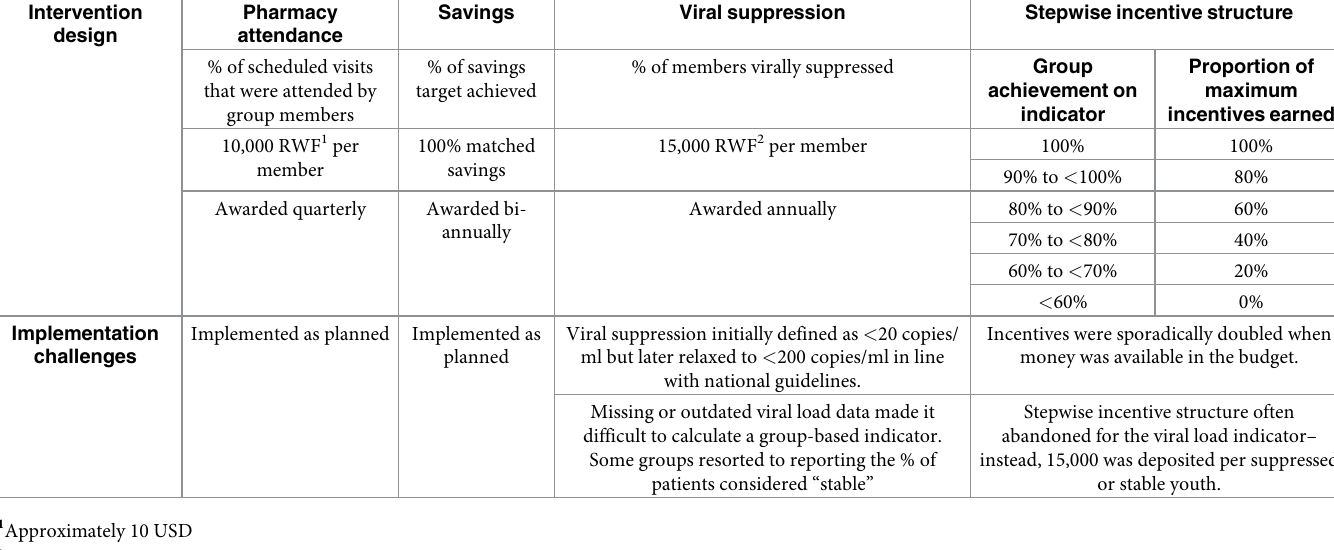
Table 1. Incentive structure for the Adolescent Support Group program. All incentives were to be deposited in a group savings account to fund subsequent income- generating activities. Intervention